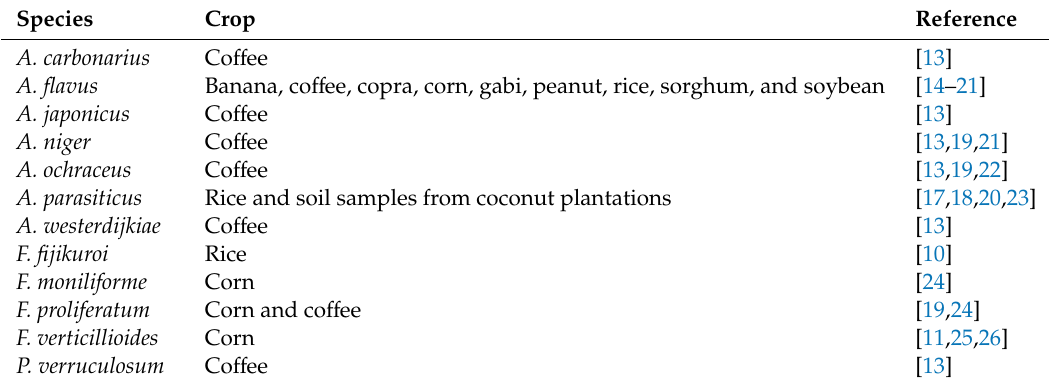
Table 1. Mycotoxigenic fungi isolated from agricultural crop commodities in the